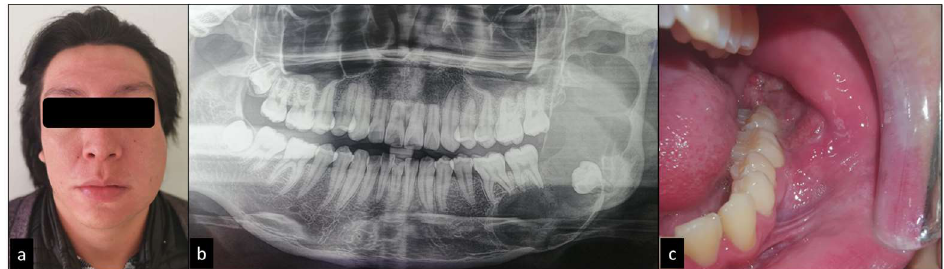
Figure 1. Clinical image. ( a ) Extraoral image shows large and diffuse swelling at middle and lower left facial third causing facial asymmetry. ( b ) Panoramic radiograph image showing a multilocular radiolucent area located in the left mandibular body that extends from the mesial root of the lower left first molar to the ramus of the mandible, with retention of the third molar. ( c ) Intraorally showed expansion of the lingual and vestibular cortices, as well as a polypoid projection in the retromolar